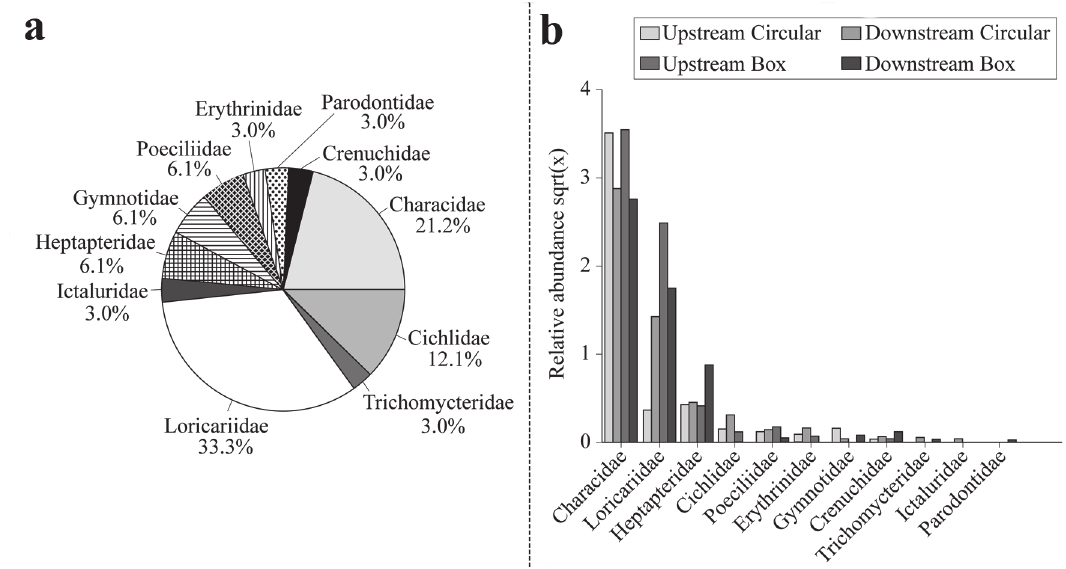
Fig. 5. Relative frequency of number of fish sampled by Family ( a ), and relative frequency of the number of fish by Family in the sampled stretches of the Lopeí stream - circular culvert and Pindorama stream - box culvert ( b